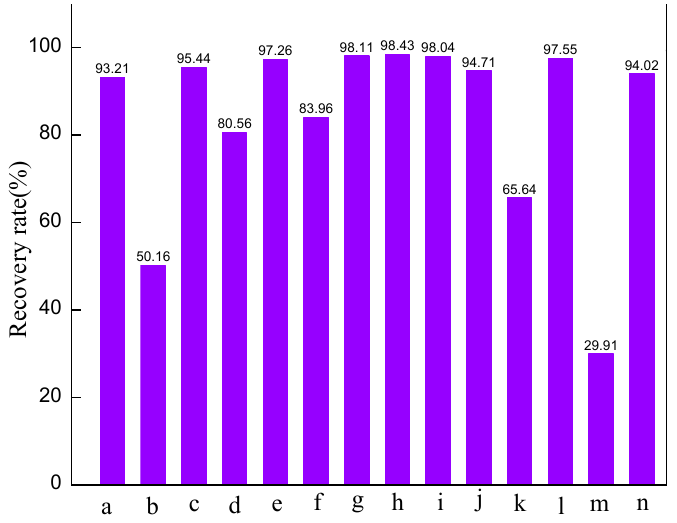
Figure 3. Effect of different inhibitors on the rolling recovery rate of shale (a, 2 %TEYA; b, water; c, 3% polydimethylamine; d, 5% emulsified asphalt; e, 5# white oil; f, 3% small cation; g, 2# oil-based drilling fluids; h, 3# oil-based drilling fluids; i, 5% KCl; j, 5%KCl+ 5% emulsified asphalt; k, 1% CaCl 2 ; l, 5% K 2 SiO 3 ; m, 5% FeCl 3 ).